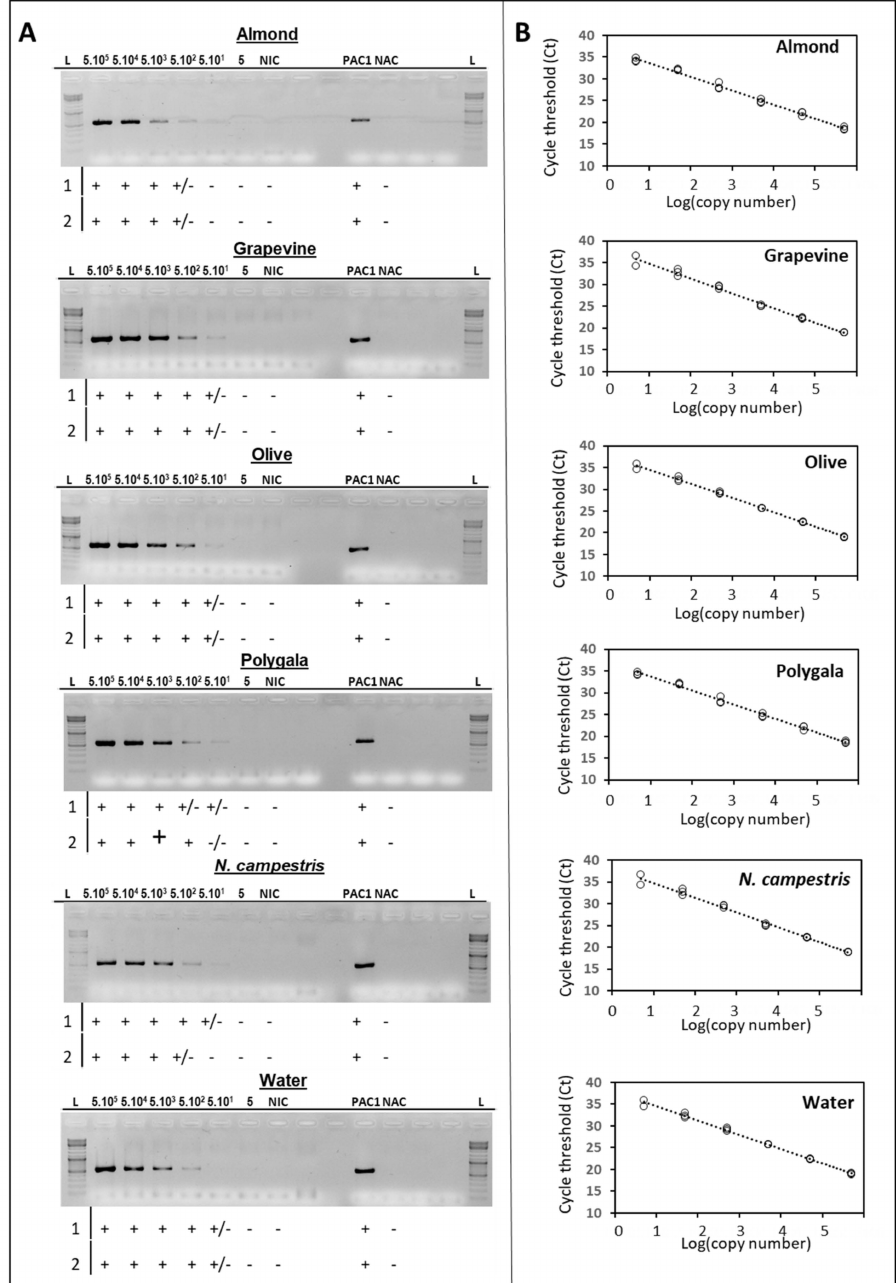
Figure 1. ( A ) Agarose gels showing the sensitivity of ND116-pRIV5-F1/ND117-pRIV5-R1 primer pair in the amplification of the tra C gene (expected amplicon size of 521 bp) using serial dilutions of Xylella fastidiosa ( Xf ) subspecies fastidiosa strain IVIA5235 DNA (from 5 × 10 5 copies/ µ L; lanes 2 to 8) singly or mixed with host DNA (almond, grapevine, olive, polygala, Neophilaenus campestris , and water). NIC: Negative isolation control included plant insect DNA only. PAC: Positive amplification control contained boiled cells of IVIA5235 strain. NAC: Negative amplification control contained DNA from a Xf strain known not to harbor the trac C gene. L: 10 kb GeneRuler™ DNA Ladder Mix (Thermo Scientific™). Data shown below agarose gels summarize the results from two independent standard DNA curves (1 and 2): +L: Positive amplification; ± : Positive weak amplification; and − : No amplification. ( B ) Cycle thresholds obtained for Harper’s qPCR using the same DNA standard curves. Data correspond to three PCR amplifications from the serial DNA standard curve number 1, shown in ( A